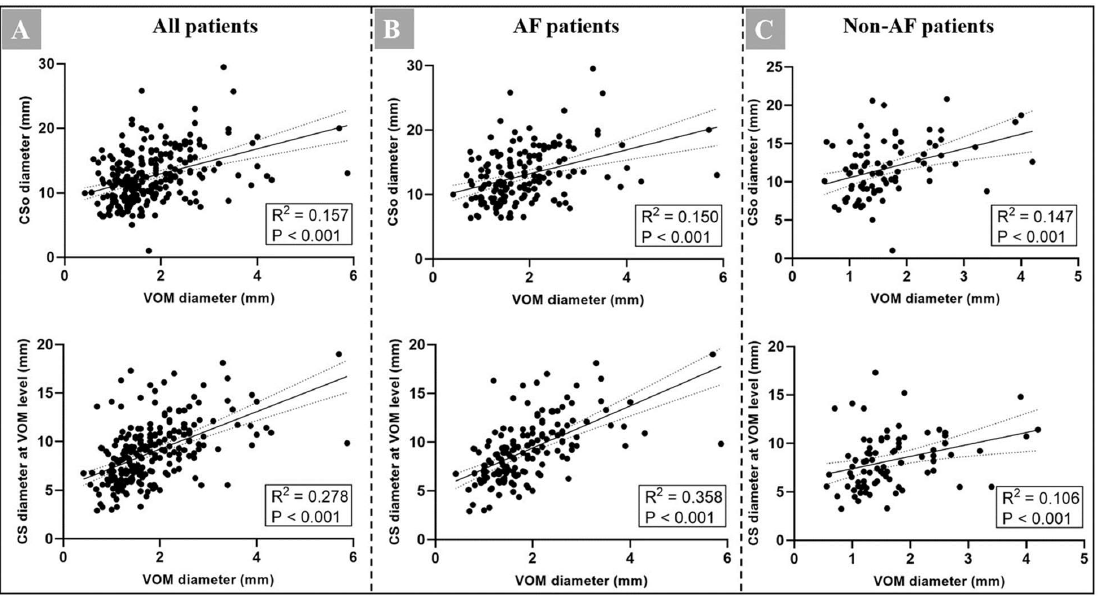
Figure 4. ( A ) Correlation between the VOM ostium diameter and age as well as LAV in all patients (n = 290); ( B ) correlation between the VOM ostium diameter and age as well as LAV in AF patients (n = 183); ( C ) correlation between the VOM diameter and age as well as LAV in non-AF patients (n = 107). AF = atrial fibrillation; CS = coronary sinus; CSo = coronary sinus ostium; LAV = left atrial volume; VOM = vein of Marshall.